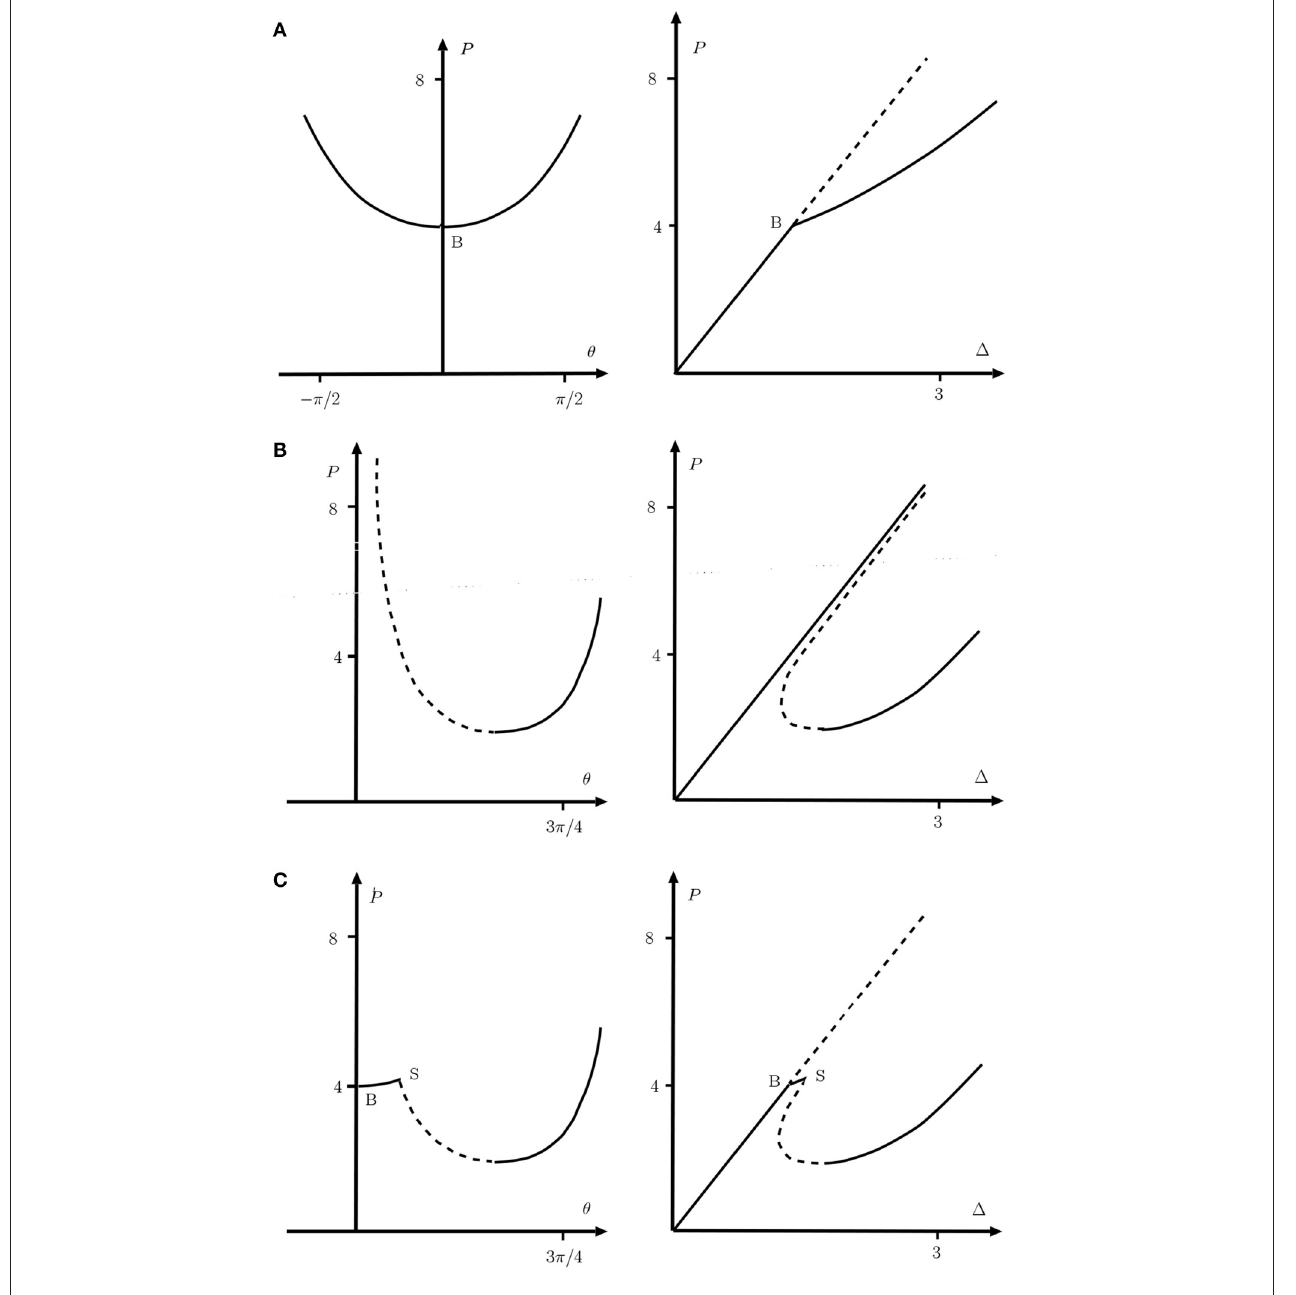
FIGURE 3 | Responses of the knee models of Figure 2 for the parameter values L (A) Elastic joint of Figure 2B . (B) Rigid-plastic joint of Figure 2C . (C) Elasto-plastic joint of Figure 2D . Unstable paths under controlled load are shown as broken